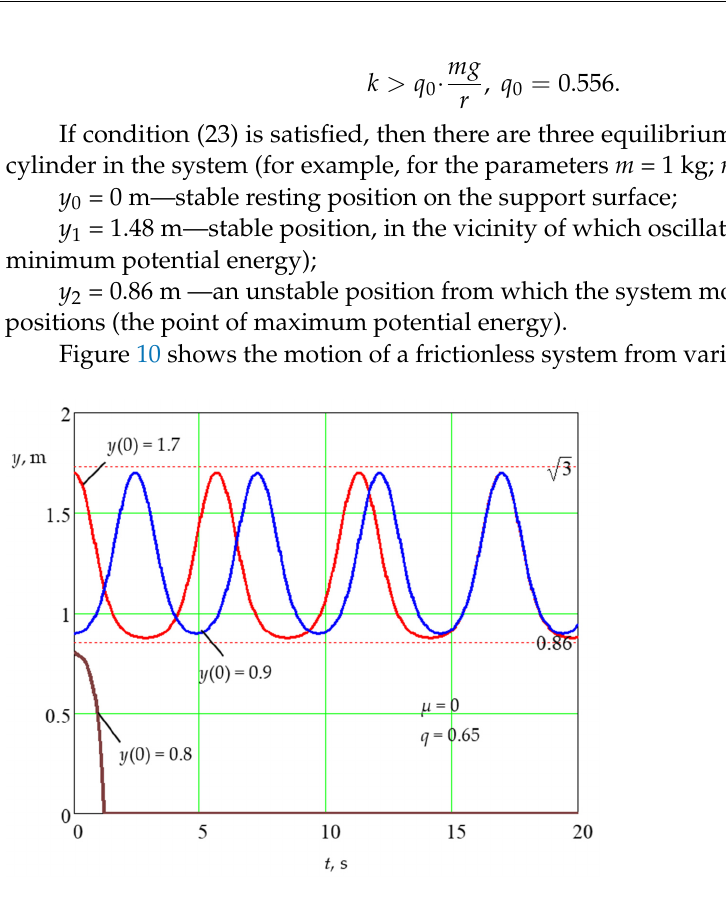
Figure 10. Movement of a system without friction from different starting points with a stiffness of the thread sufficient for the occurrence of free vibrations.